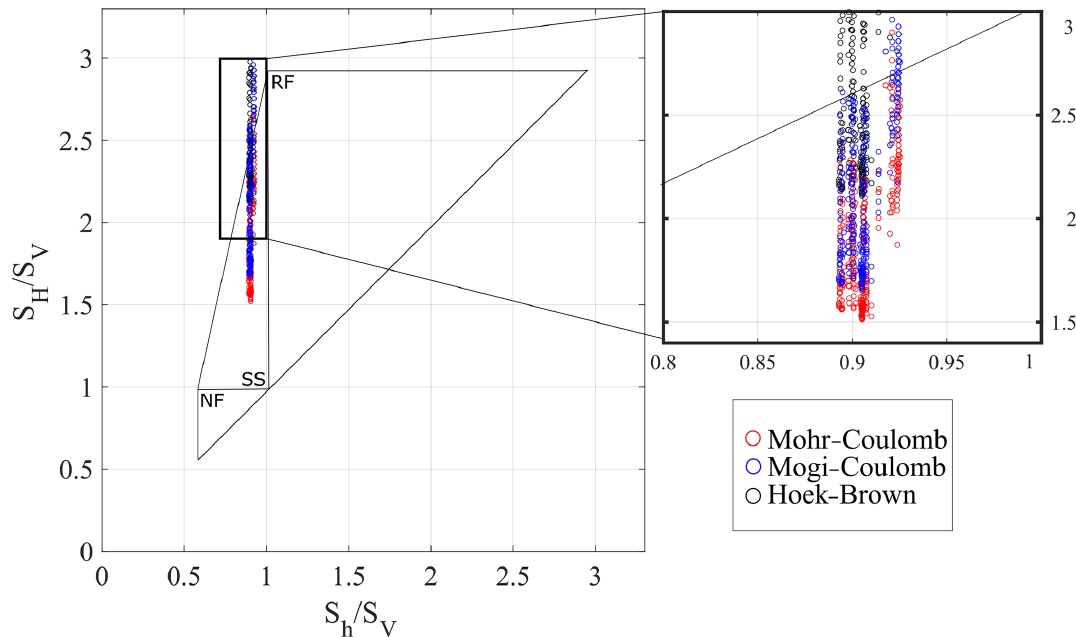
Figure 16. Normalized stress polygon defining stress states ( S H /S V , S h /S V ) at a depth of 2500m in GRT-1, according to a Coulomb law with a coefficient of friction µ = 1. The borders of the polygon correspond to an active fault situation. RF – reverse faulting, SS – strike-slip regime and NF – normal faulting refer to Anderson’s faulting regimes. The plot includes stresses ( S H /S V – S h /S V ) calculated from the image of GRT-1 from 2013 for three different failure criteria (circles in color).